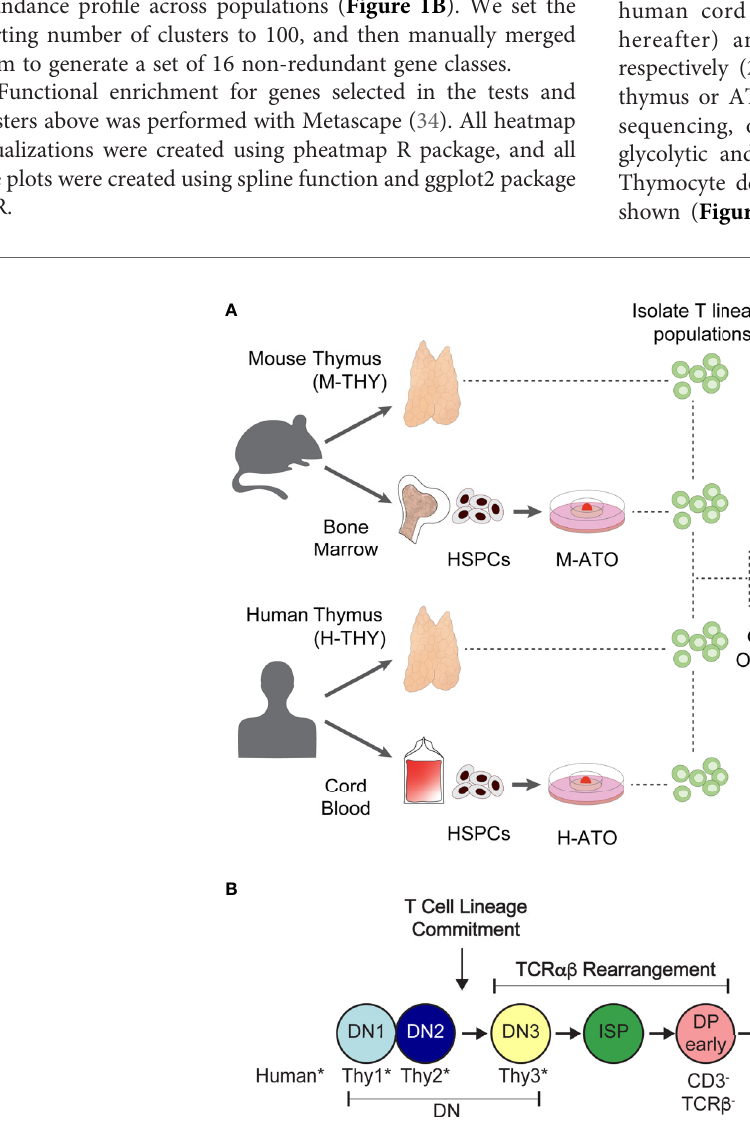
FIGURE 1 | (A) Experimental schema for metabolic analysis of murine and human T cell development in primary thymus and in vitro ATO cultures. HSPCs isolated from mouse bone marrow or human cord blood were seeded in M-ATO and H-ATO systems respectively. T lineage populations isolated from each tissue were subject to RNA-seq or extracellular fl ux measurements to determine glycolytic and respiration rates (Seahorse Assay). Metabolic transcriptional and fl ux results were integrated to determine statistical correlation between datasets. (B) Schematic of T lineage populations isolated for RNA-seq analyses or Seahorse Assays. Detailed population phenotypes for isolation are provided in Supplementary Table 1 . (*DN populations are named DN1-3 in mouse, and Thy1-3 in